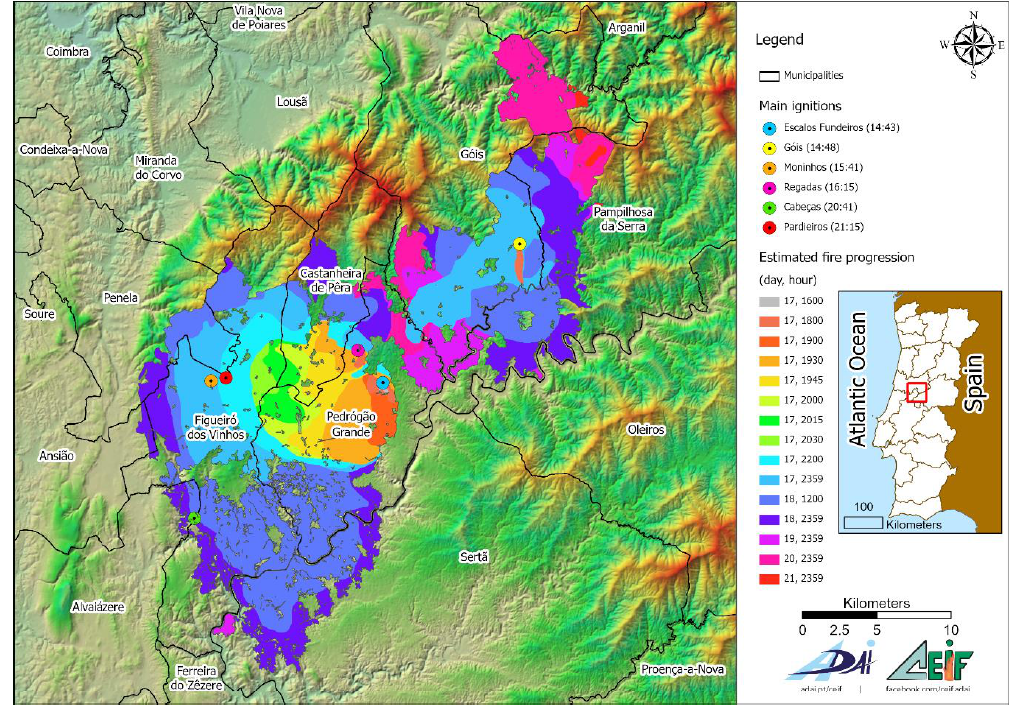
Figure 1. Estimated fire progression and main ignitions.